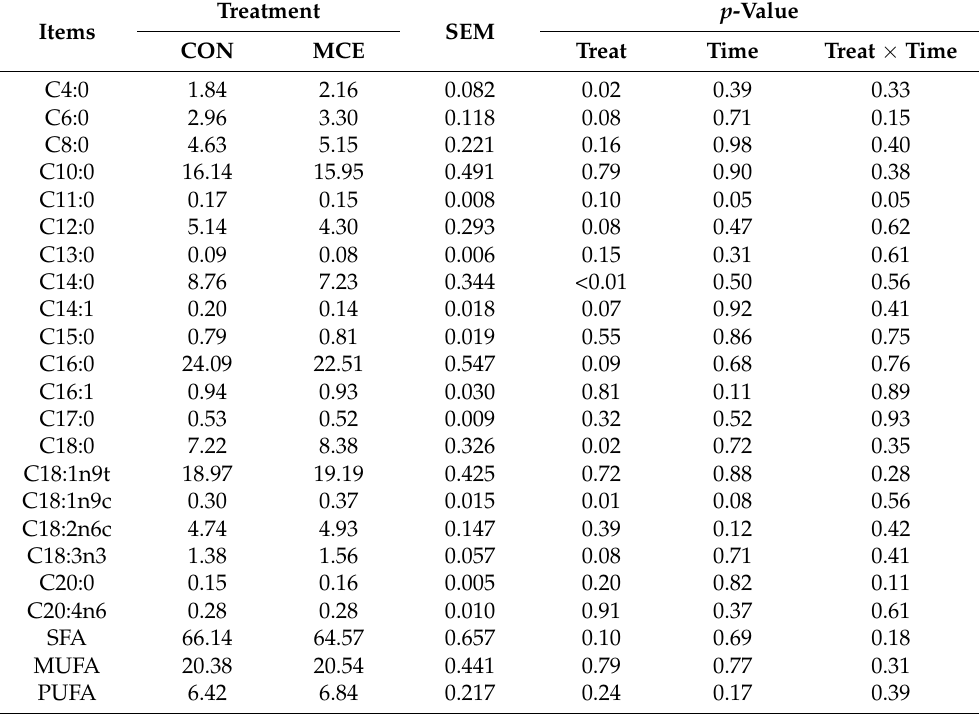
Table 4. Effect of MCE on milk fatty acid composition